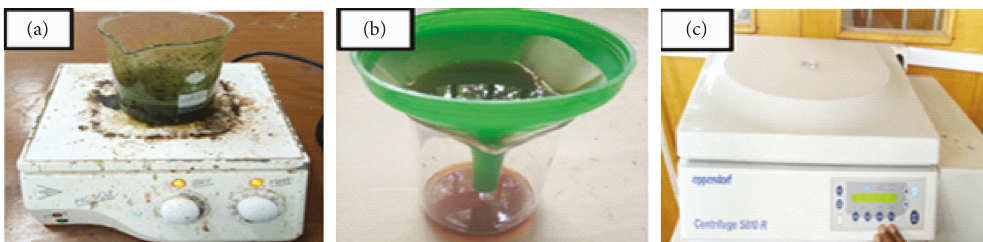
Figure 3: (a) Magnetic stirrer. (b) Whatman paper filtration. (c) Centrifugation